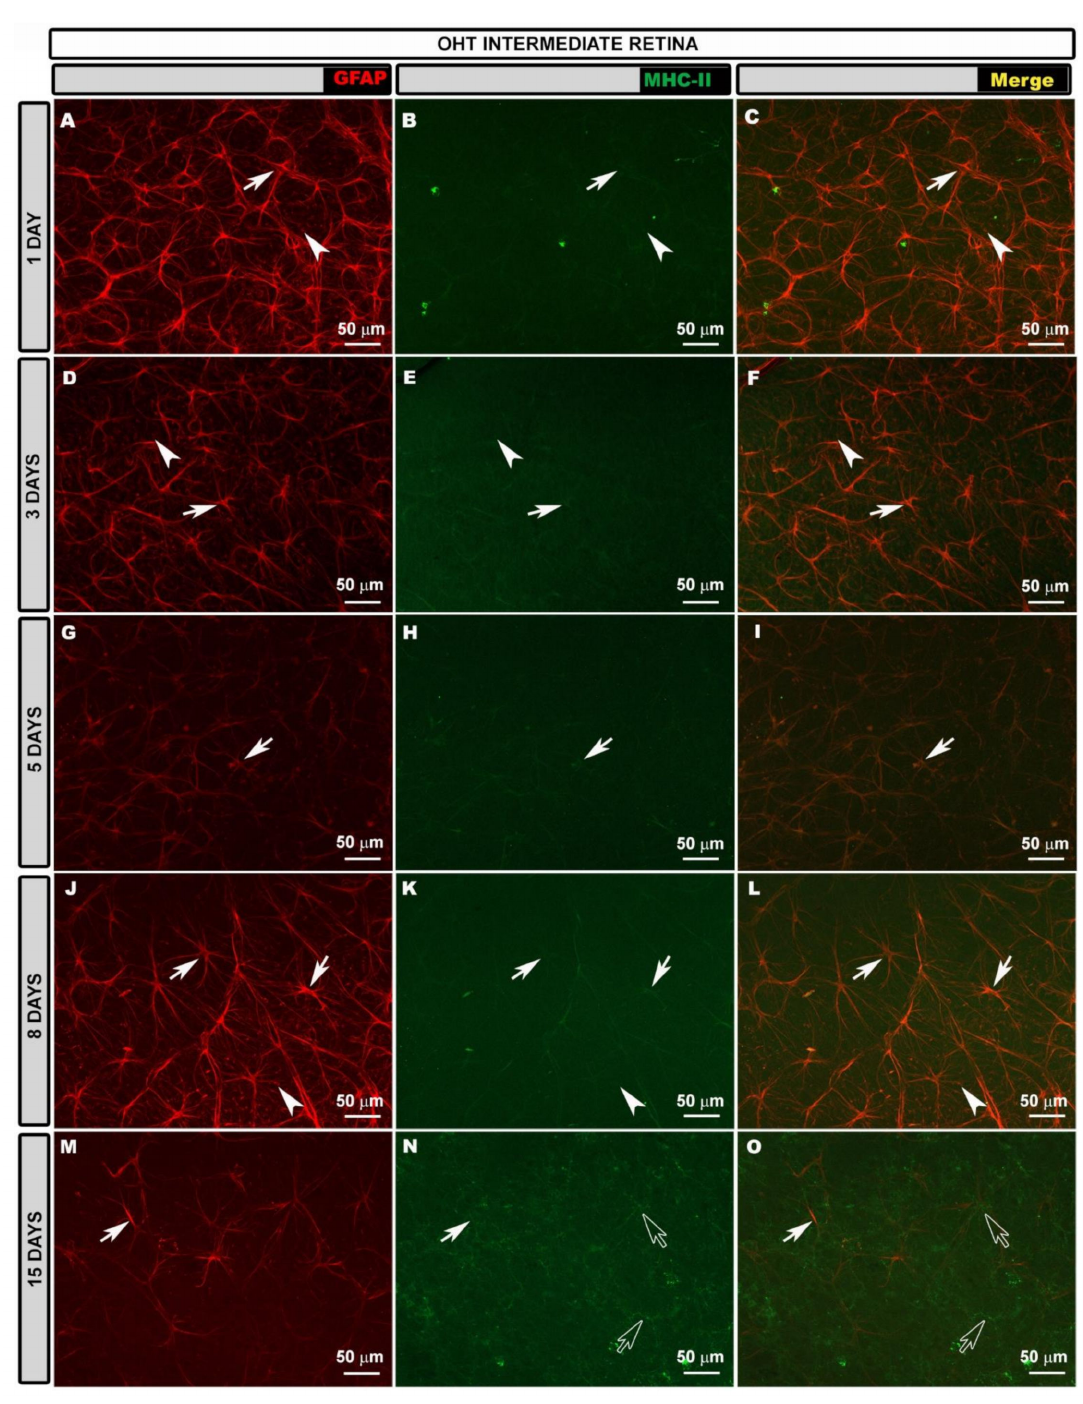
Figure 6. Retinal whole-mount. Double immunostaining for GFAP (red) and MHC-II (green) at differ- ent time points after OHT induction in OHT eyes in the intermediate retina. GFAP-labeled astrocytes are shown at different time points ( A , D , G , J , M ). In the intermediate retina, MHC-II expression by astrocytes (arrow) was slightly higher than that found in the retina near to the OD at all time points (1 ( B , C ); 3 ( E , F ); 5 ( H , I ); 8 ( K , L ); and 15 ( N , O ) days) after OHT induction. At 15 days after laser treatment ( N , O ), intense MHC-II expression by microglia (hollow arrowhead) was observed. The arrowhead points to the terminal feet of Müller glia. GFAP: glial fibrillary acidic protein; MHC-II: major histocompatibility complex class II; OHT: ocular hypertension; OD: optic